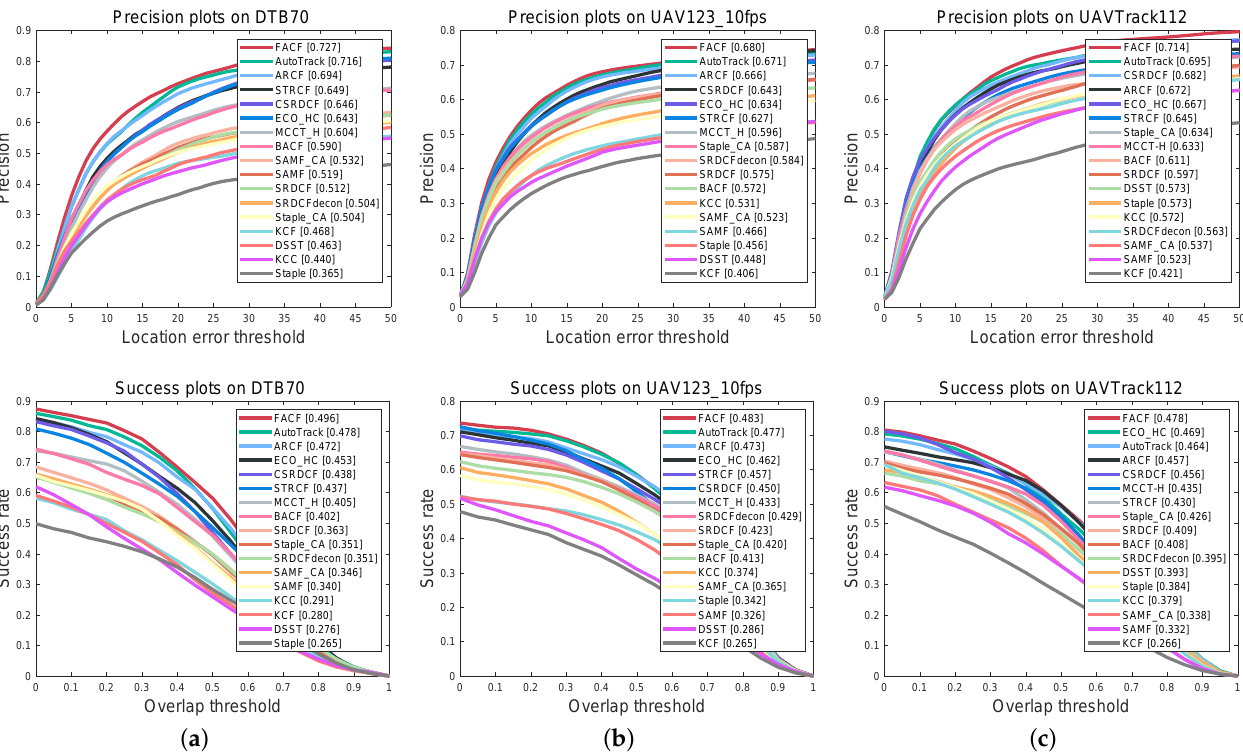
Figure 5. Overall performance comparison of the proposed FACF tracker and other 16 state-of-the-art handcrafted feature- based trackers on ( a ) DTB70 [25], ( b ) UAV123_10fps [26], and ( c ) UAVTrack112 [27]. First row: precision plots. Second row: success